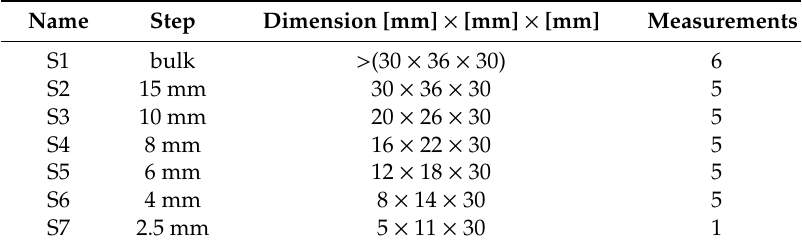
Table 1. Dual-needle sensor sensitivity study; measurements